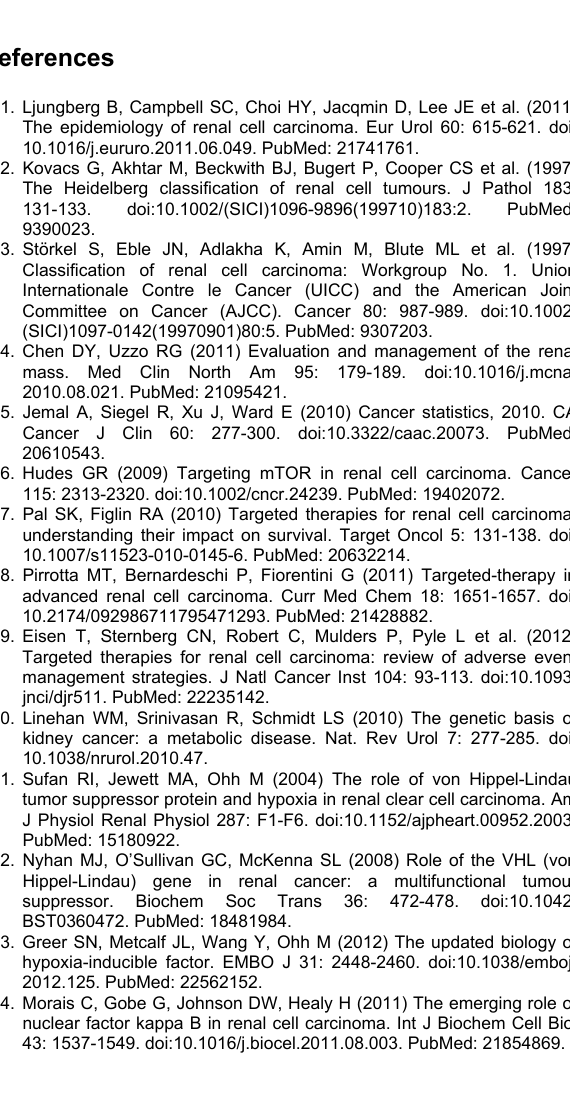
Figure S1. Flowchart outlining study methodology.